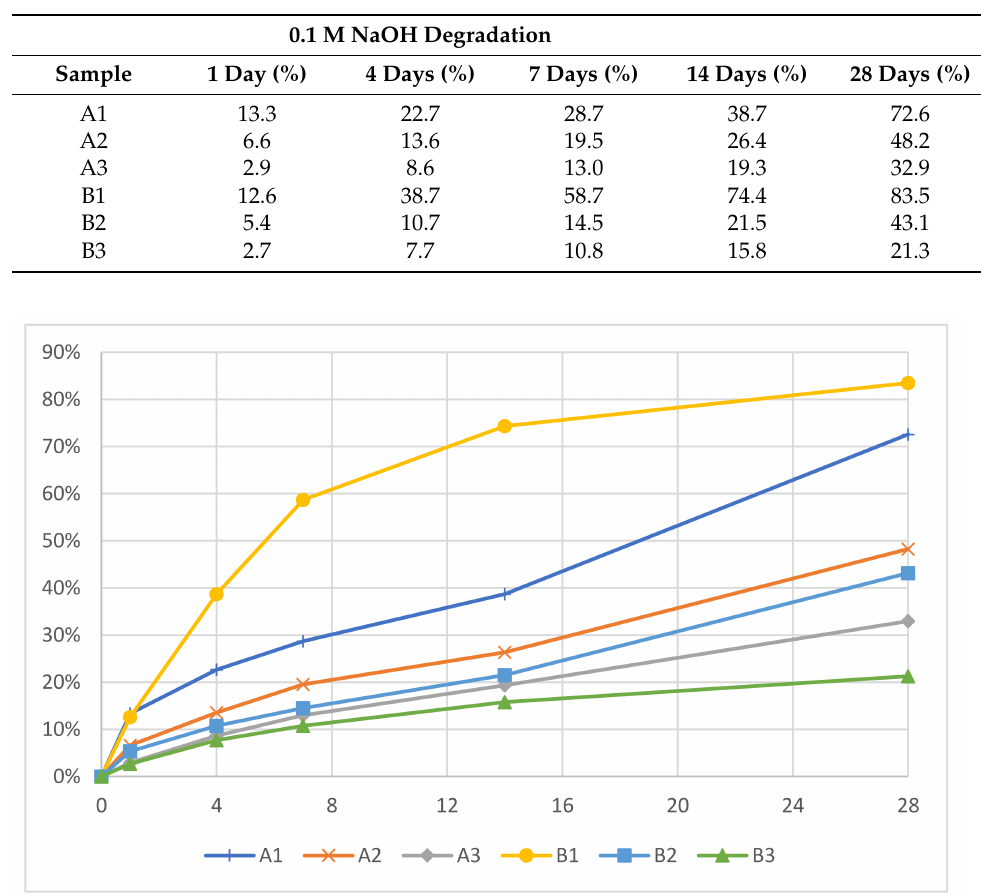
Figure 5. Degradation degrees of the polyHIPE microspheres. The availability of free thiol groups was evaluated using Ellman’s assay, as free thiol groups would be used for further functionalizations of the material. Sample B1 had 74.04 µ mol/g of available thiol groups, whereas B3 had 19.98 µ mol/g of available